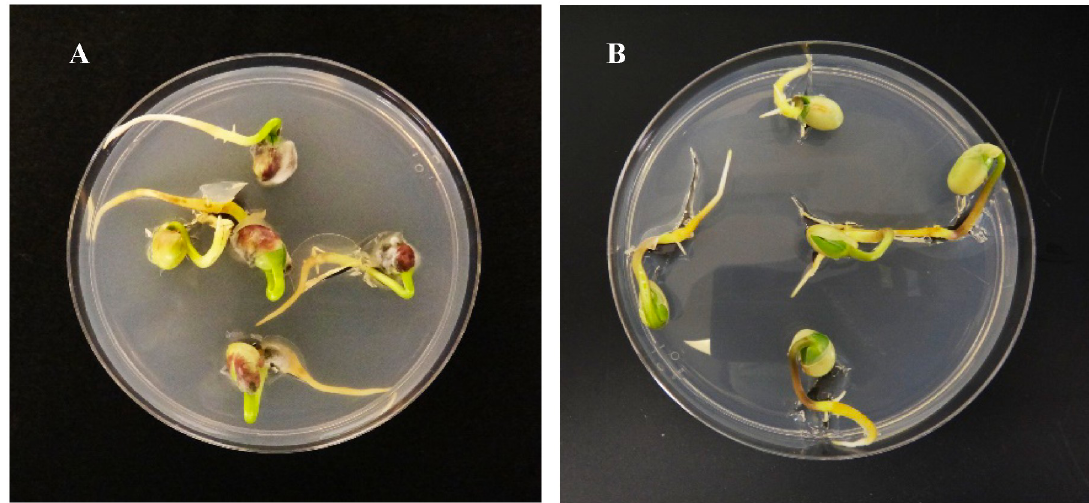
Fig 3. Seed plating assays on acidified potato dextrose agar (APDA). A . A susceptible genotype, AP 350, plated on APDA. B . A resistant genotype, PI 264555, plated on APDA.